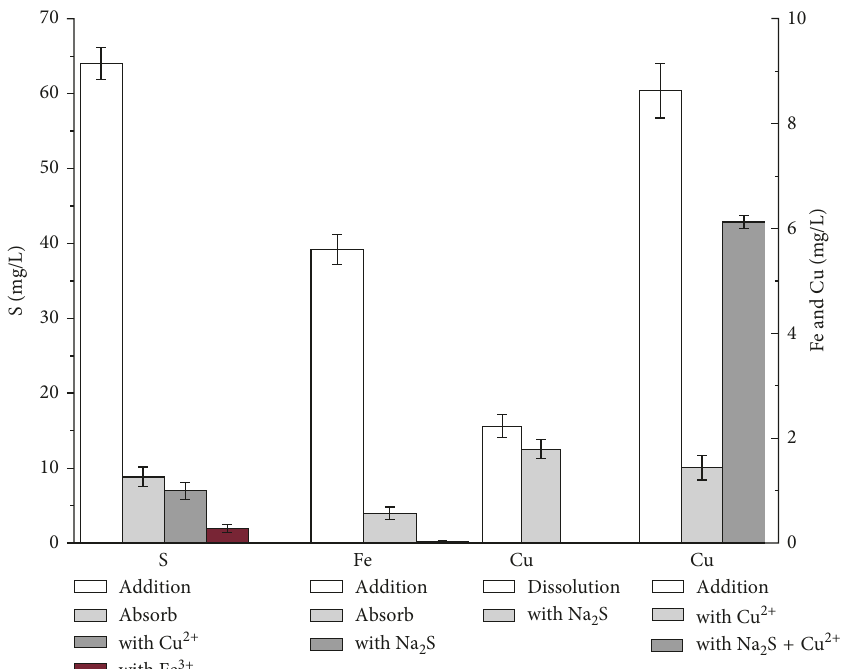
Figure 7: ICP results of the CuO solution with adsorbed ions.